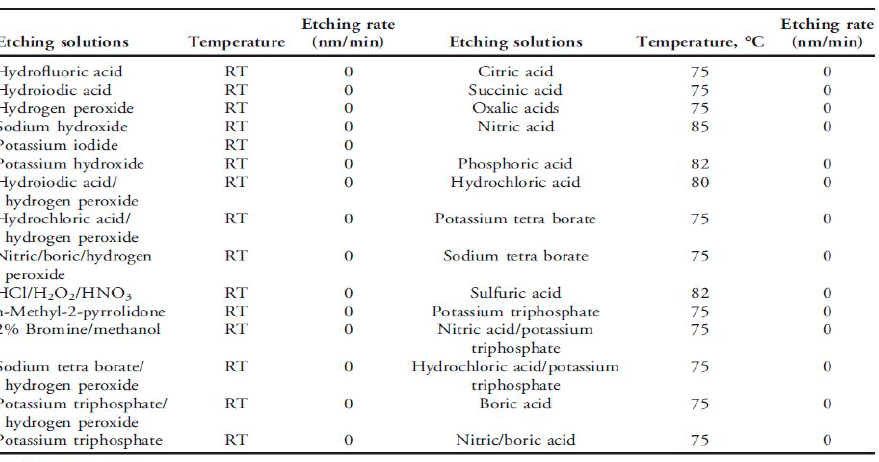
Figure 1. Leaching GaN with Various Chemical Reagents.